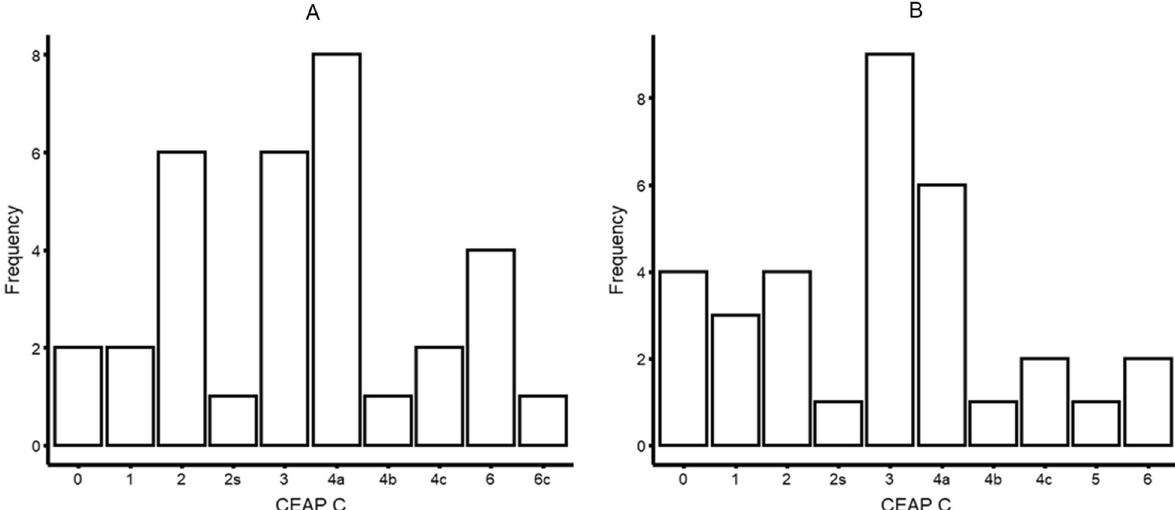
Fig. 2 CEAP C class in the study population. A right leg, B left leg. C0 C3 Edema, C4 Skin changes, C5 = =